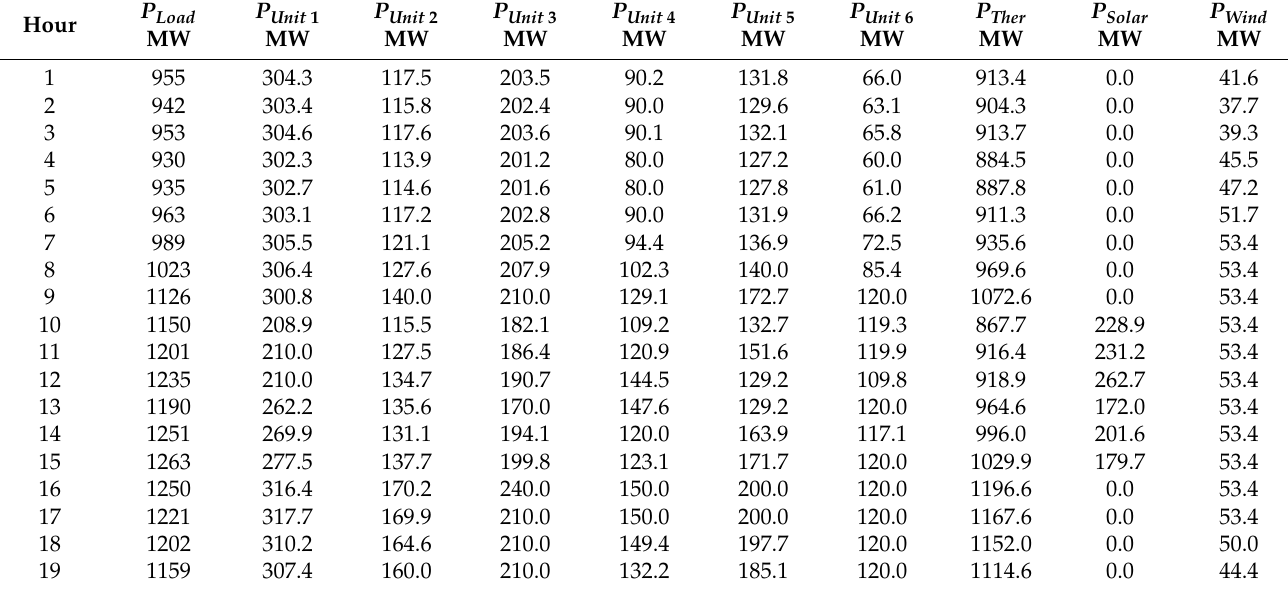
Table 15. Hourly load demand and power generation values—case study